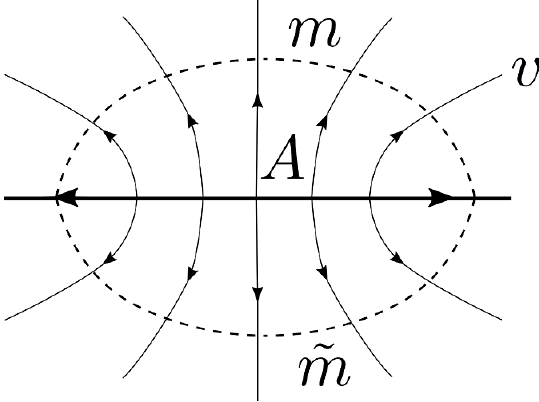
Figure 2 . By gluing two copies of the time slice (cid:6) along the boundary @ (cid:6), we create a boundaryless surface m [ ~ m . The GHY term is accounted for by the integral of ~ R over where m and ~ m